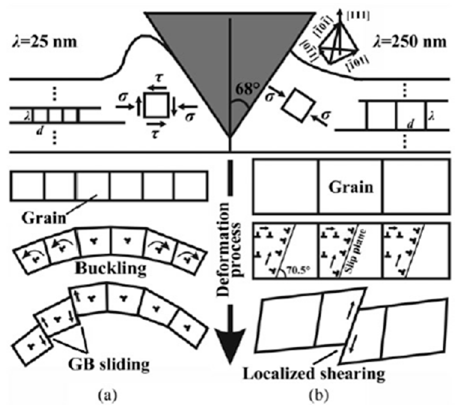
Figure 25. SEM cross-section view of two different deformation mechanisms corresponding to buckling-assisted layer rotation of ( a ) Au/Cu multilayer with h = 25 nm and dislocation plasticity-dominated shearing of ( b ) Au/Cu multilayer with h = 250 nm [146].